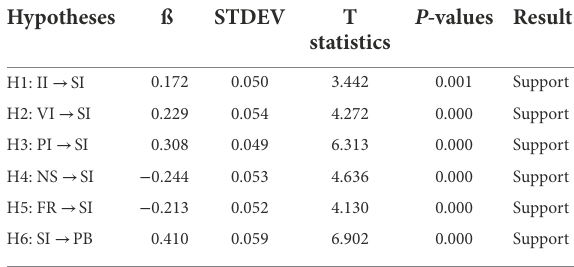
TABLE 5 Hypothesis testing results.